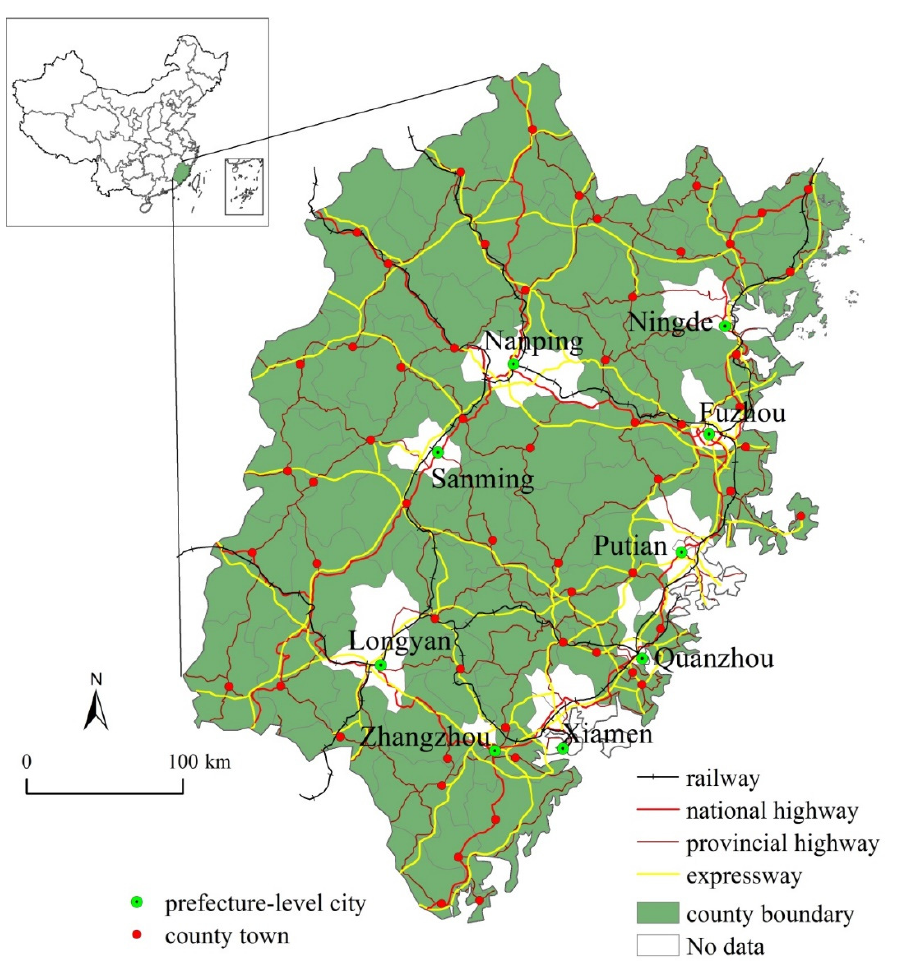
Figure 1. Location, cities, counties and land transportation infrastructure of Fujian province.